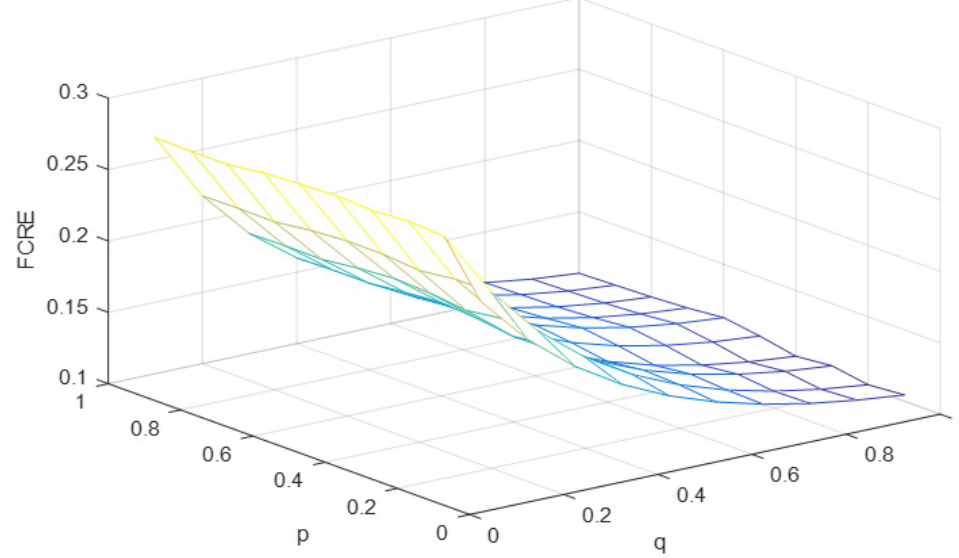
Figure 1. The relationship among fractional cumulative residual entropy, fractional order q , and probability P for typical examples of the uniform distribution on [0, 1] .